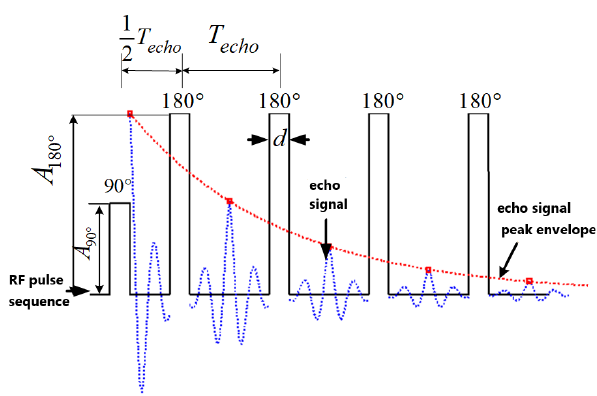
Figure 2. CPMG pulse sequence and echo.